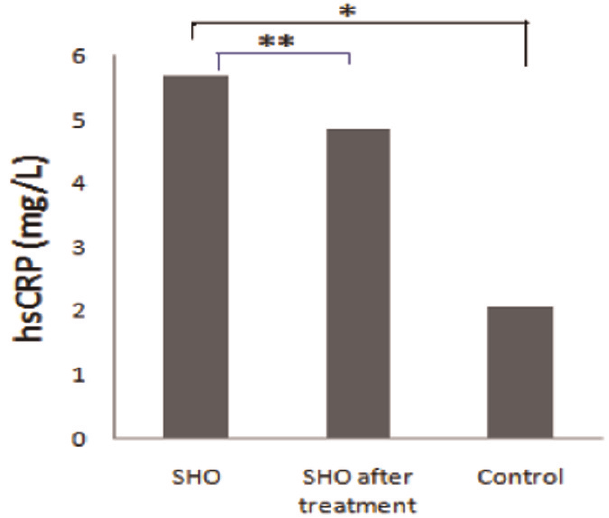
Figure 1 - Comparisons of hs-CRP level in SHO group, SHO patients after treatment and healthy controls. (* p , 0.001) (** p =0.440) Abbreviation: SHO, subclinical